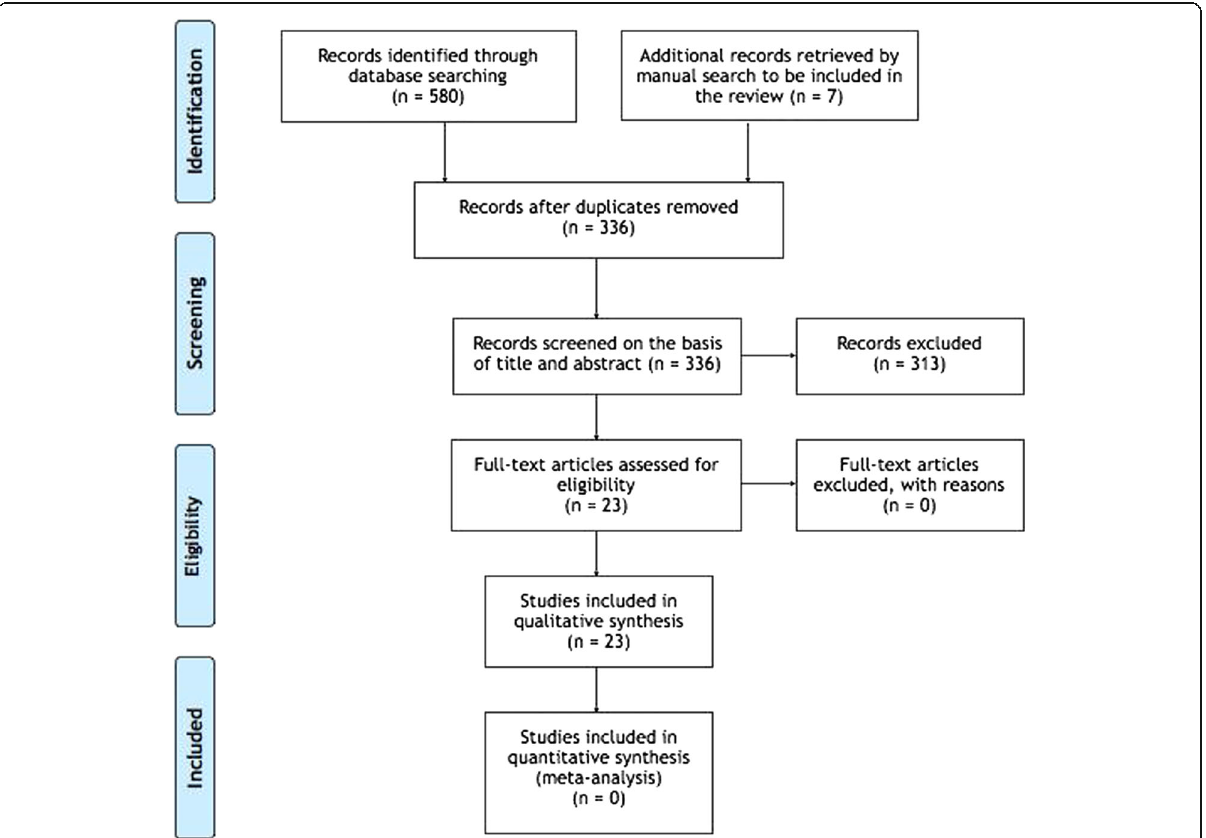
Fig. 1 Flow chart of the selection of the